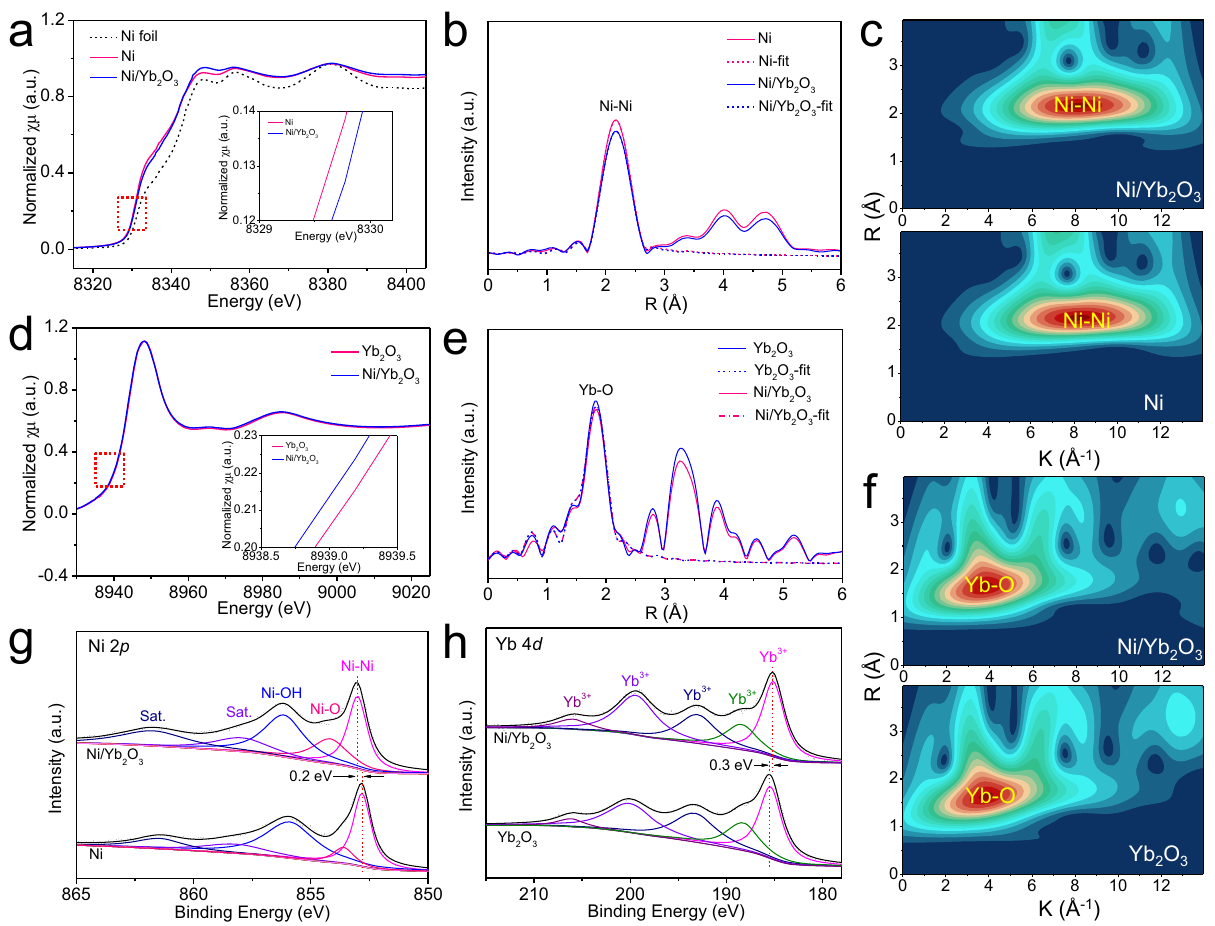
Fig. 4 Spectroscopic characterizations of Ni/Yb 2 O 3 hybrid. a Ni K-edge XANES spectra of Ni/Yb 2 O 3 , pristine Ni, and Ni foil reference. b , c Fourier transforms and wavelet transforms of EXAFS spectra for Ni/Yb 2 O 3 and pristine Ni. d Yb L-edge XANES spectra of Ni/Yb 2 O 3 and pristine Yb 2 O 3 . e , f Fourier transforms and wavelet transforms of EXAFS spectra for Ni/Yb 2 O 3 and pristine Yb 2 O 3 . g Ni 2 p XPS spectra of Ni/Yb 2 O 3 and pristine Ni. h Yb 4 d XPS spectra of Ni/Yb 2 O 3 and pristine Yb 2 O 3